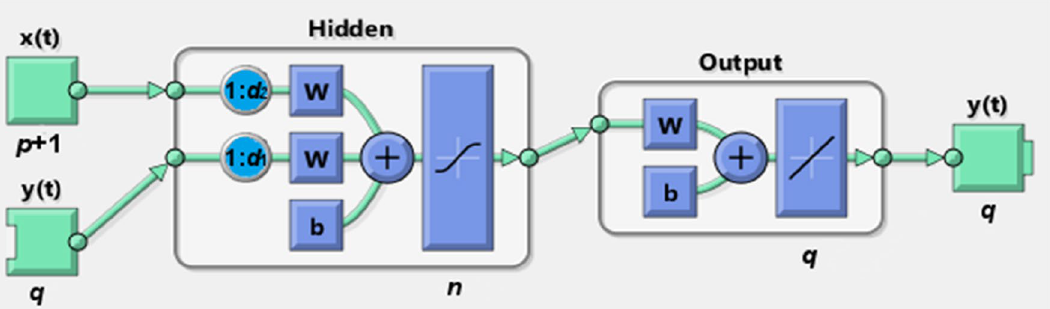
Figure 1. An overview of NARXNN